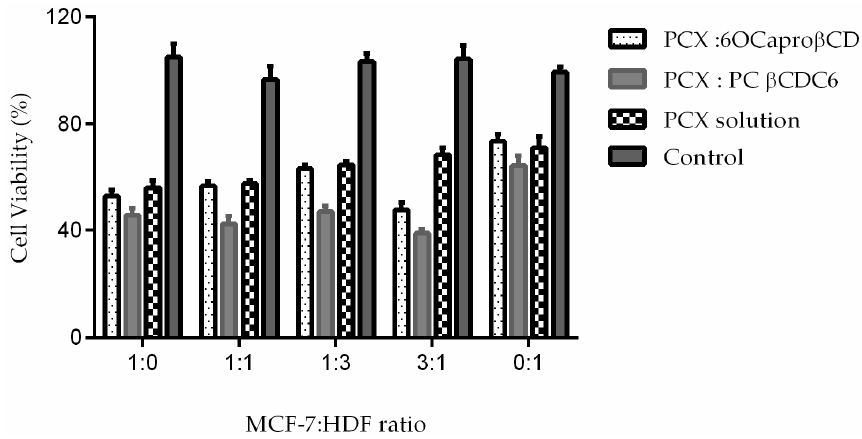
Figure 14. Antitumoral effect of PCX loaded nanoparticles were prepared from inclusion complex on 3D tumor spheroids ( n = 6, ±SD).